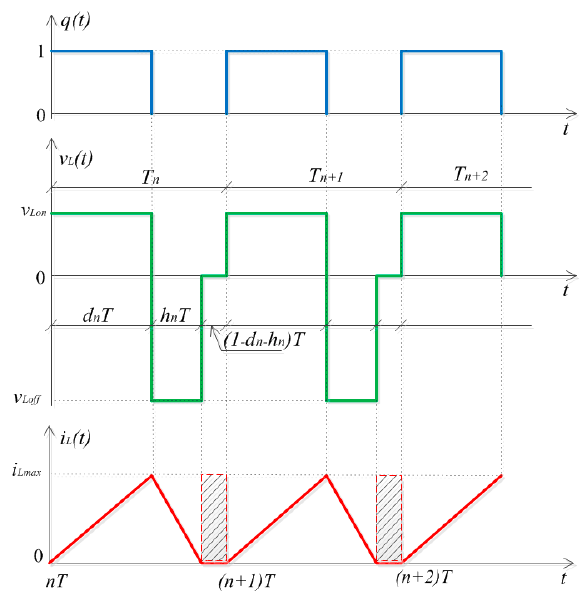
Figure 1. Transistor switching function, inductor voltage and inductor current in a DCM operated dc-dc converter.